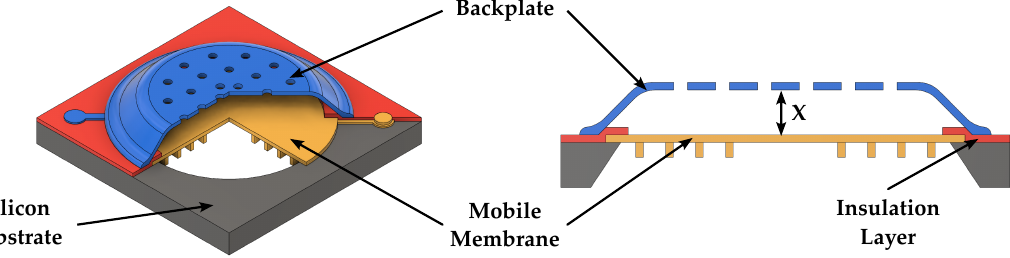
Figure 4. Schematic 3D view and cross section of a capacitive